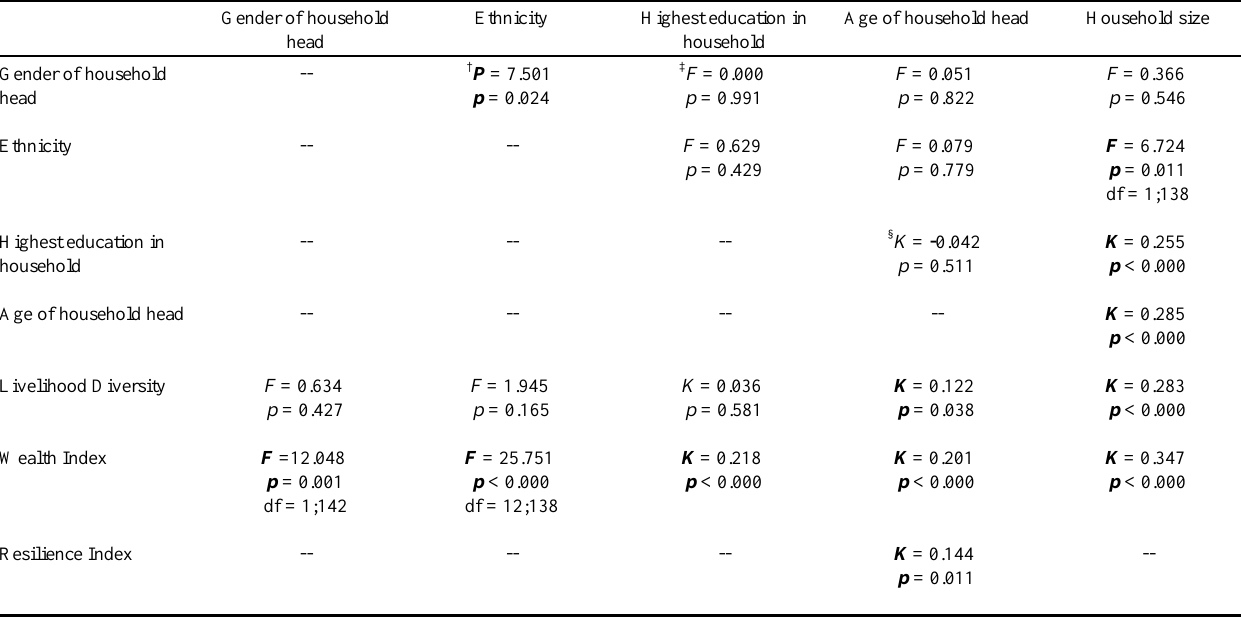
Table 1 . Measures of association between key sociocultural characteristics and the Livelihood Diversity Index and Wealth